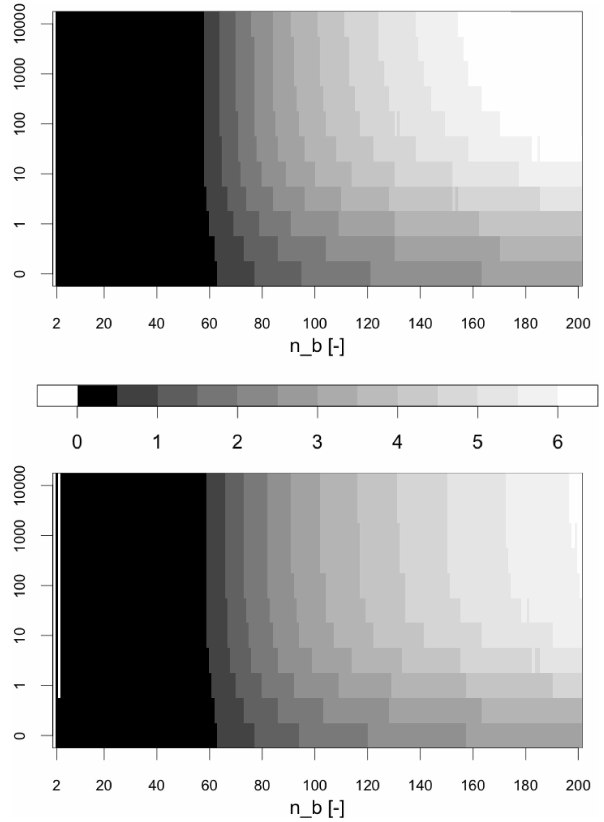
Figure 1. Influence of a f on the results measured in x sd , displayed as shadings of gray, of the KLD (upper figure) and JSD (lower figure) for di ff erent number of bins n b .